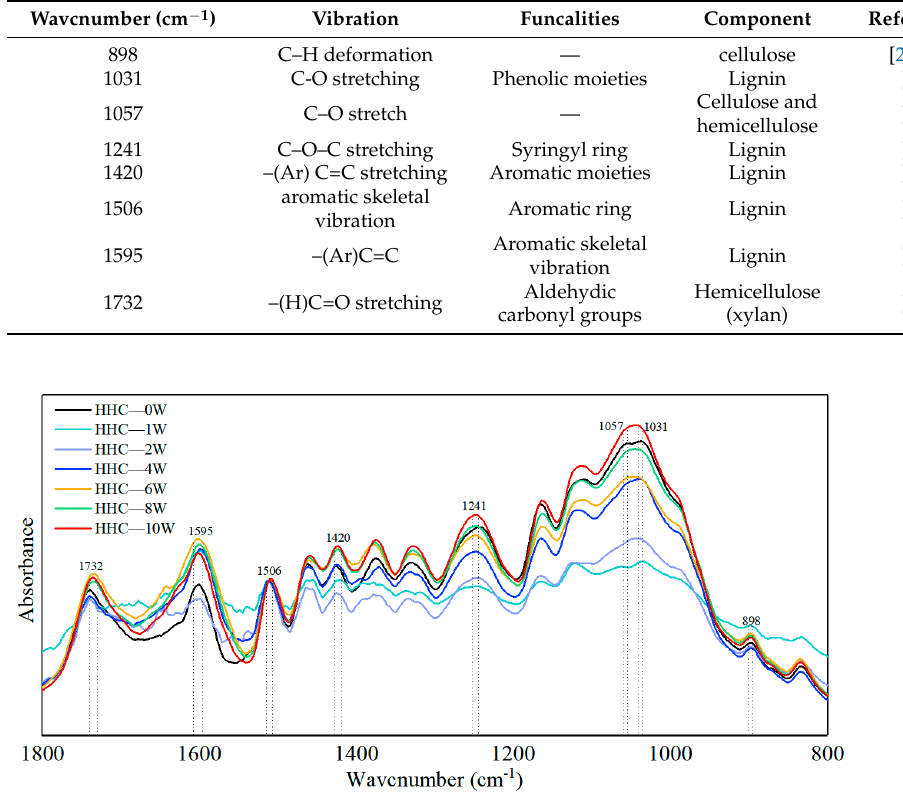
Figure 7. Fourier infrared spectra of bamboo during humidity and heat ageing.